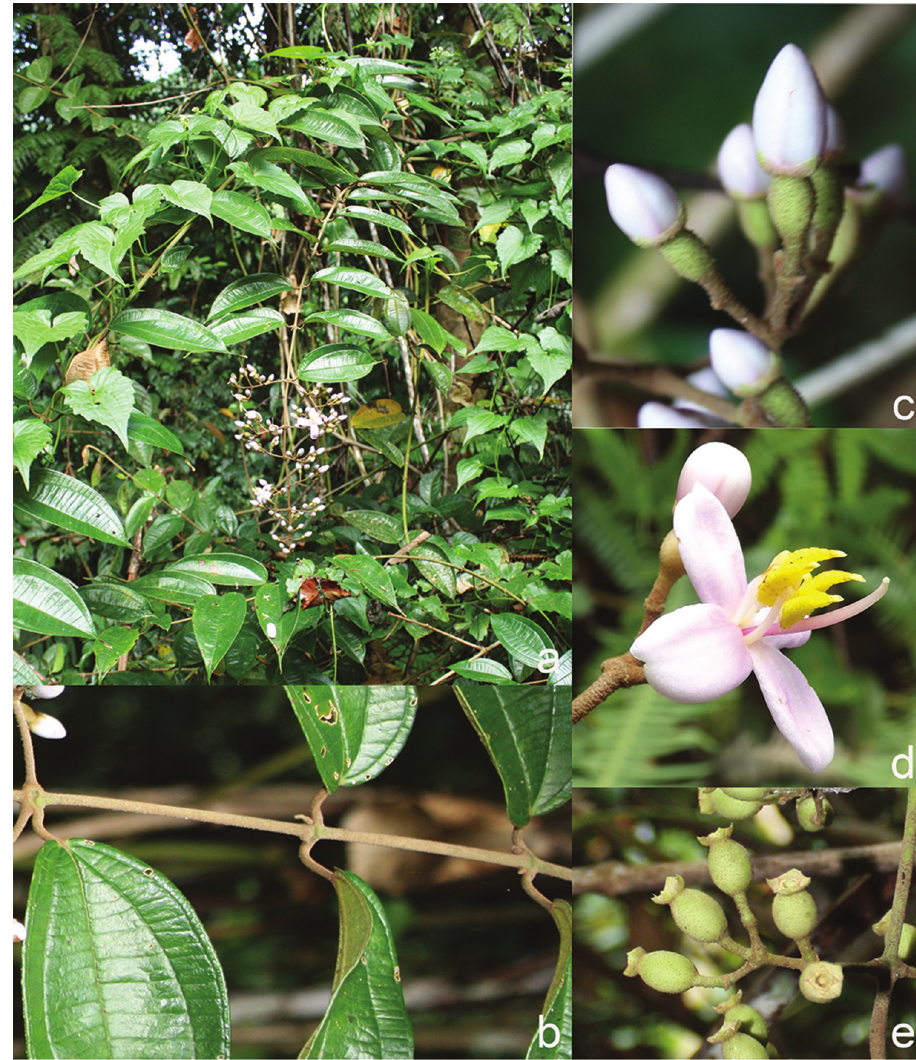
Figure 13. Dissochaeta fallax . a habit b branchlet c hypanthium d Flower e immature fruits. Photo- graphs by A. Kartonegoro; vouchers: Kartonegoro 1106 (BO, L). medifixed, thecae 3–6.5 mm long, bright yellow, beaked, pedoconnective not devel- oped, basal crests triangular, orbicular or ligular, 1–3 mm long, attached to the attach- ment of the filament, white, lateral appendages absent; the oppositipetalous stamens smaller, with 2–3 mm long filaments, anthers oblong, oblong-lanceolate, medifixed, thecae 2–4 mm long, tessellate-reticulate, yellow, basal crests ligular, erect or sometimes tapering horizontally inward to the anther, 1–1.5 mm long, lateral appendages absent. Ovary half or ⅔ of hypanthium in length, apex pubescent; style 7–15 mm long,